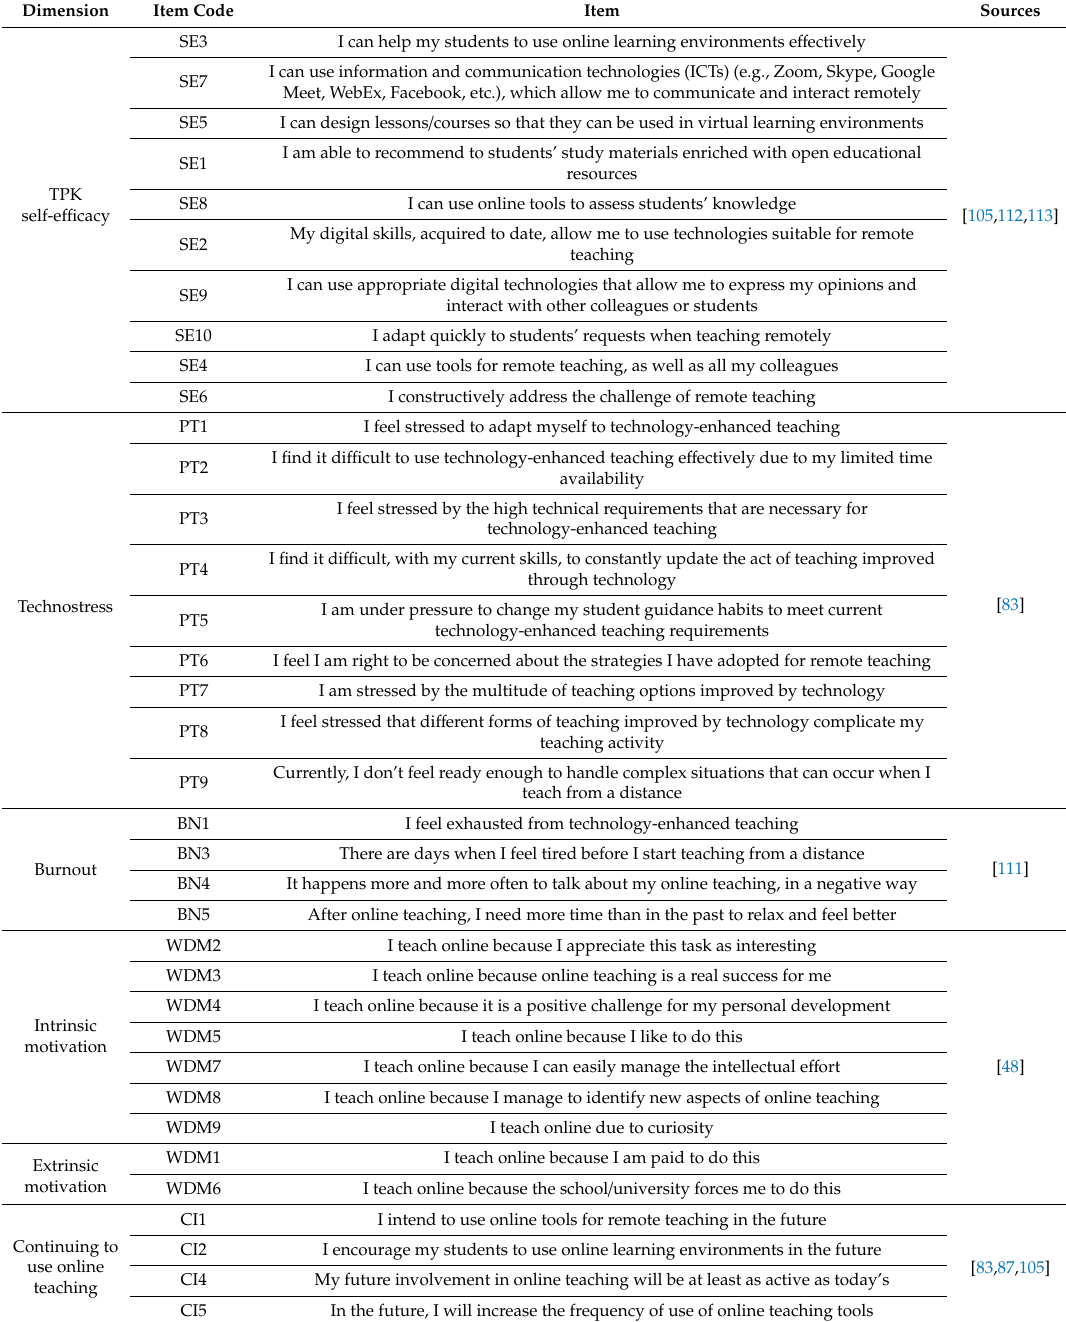
Table A1. Initial research